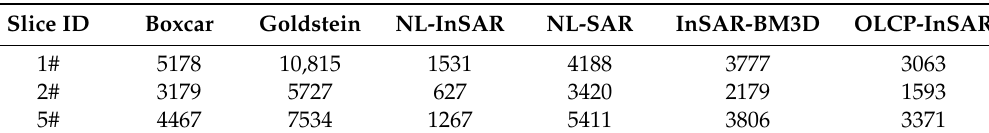
Table 6. Residues remaining in the filtered interferograms.